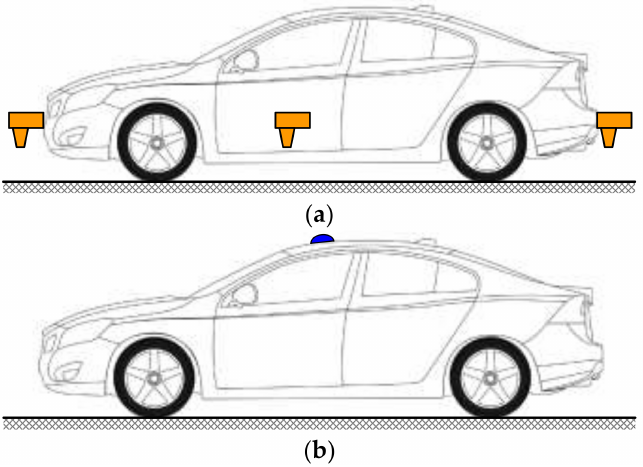
Figure 1. Schematic diagram of installation positions of standard instruments using various sensors: ( a ) the non-contact optical speed sensor; ( b ) the GPS speed